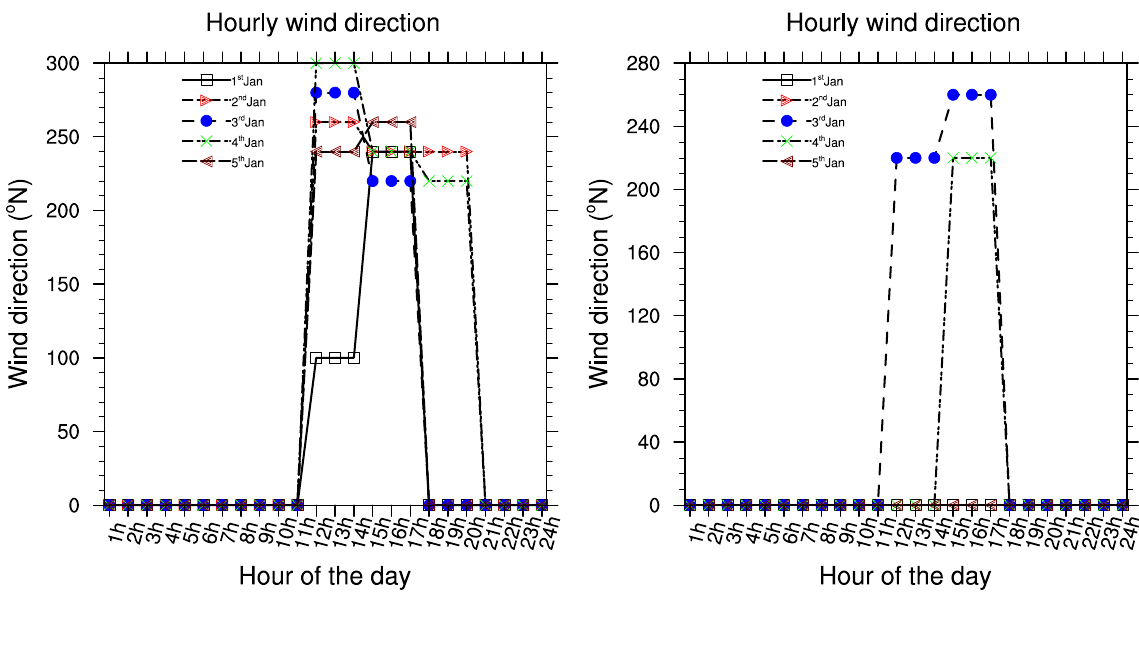
Figure 3. Daily wind direction for the first five days of the months of January, May and August from 2004 to 2005. The first label is for the year 2004 and the second label (column) is for the year